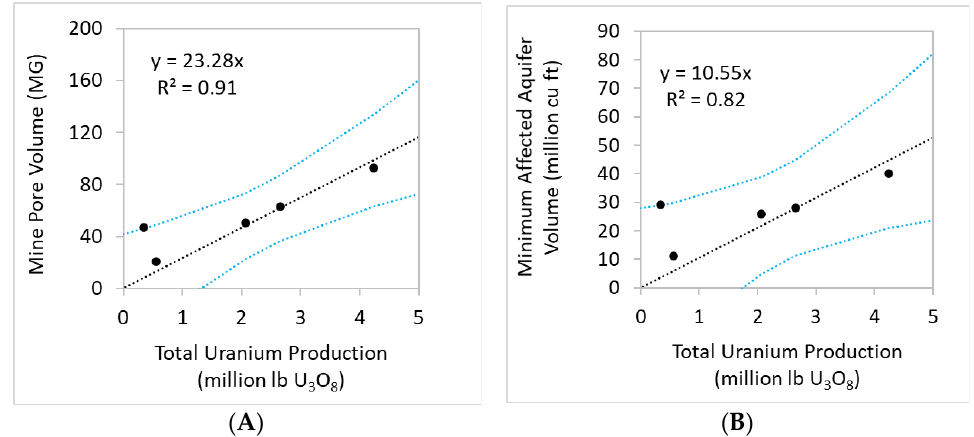
Figure 8. ( A ) Mine pore volume and ( B ) minimum affected aquifer volume as a function of uranium produced (as lb U 3 O 8 ) for Kingsville Dome, Mt. Lucas, Palangana Dome, Palangana and Rosita. Alta Mesa was not included because a pore volume was not reported. Compiled data used to construct these graphs as well as associated references are publicly available online [18]. Note: MG = million gallons, cu ft = cubic feet. Black line is the linear trend line and blue lines are the 95 percent confidence intervals.